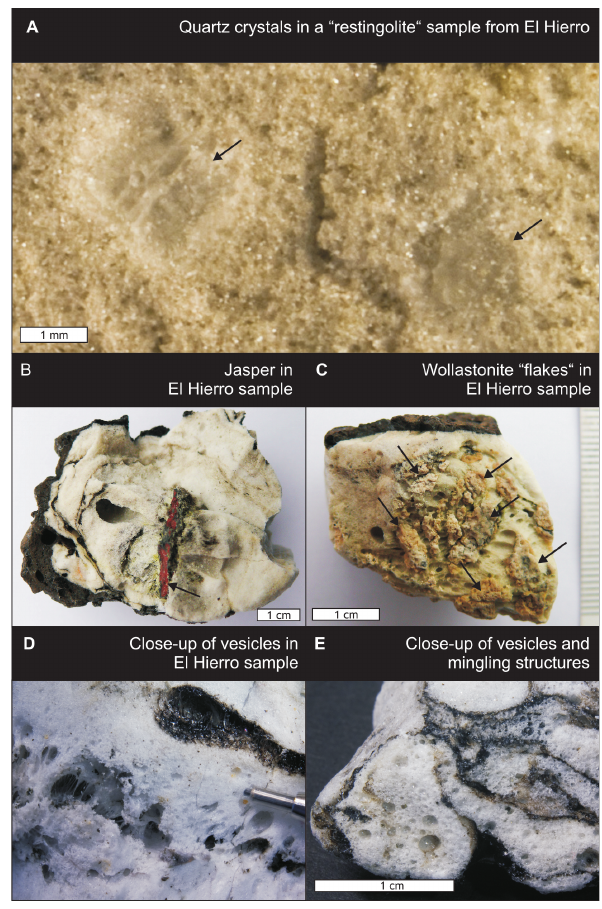
Fig. 3. Overview of small-scale features of early floating stones (“restingolites”) from El Hierro. (A) mm-size quartz crystals. (B) Jasper inclusions (C) Wollastonite “flakes”. (D and E) Vesi- cles and mingling